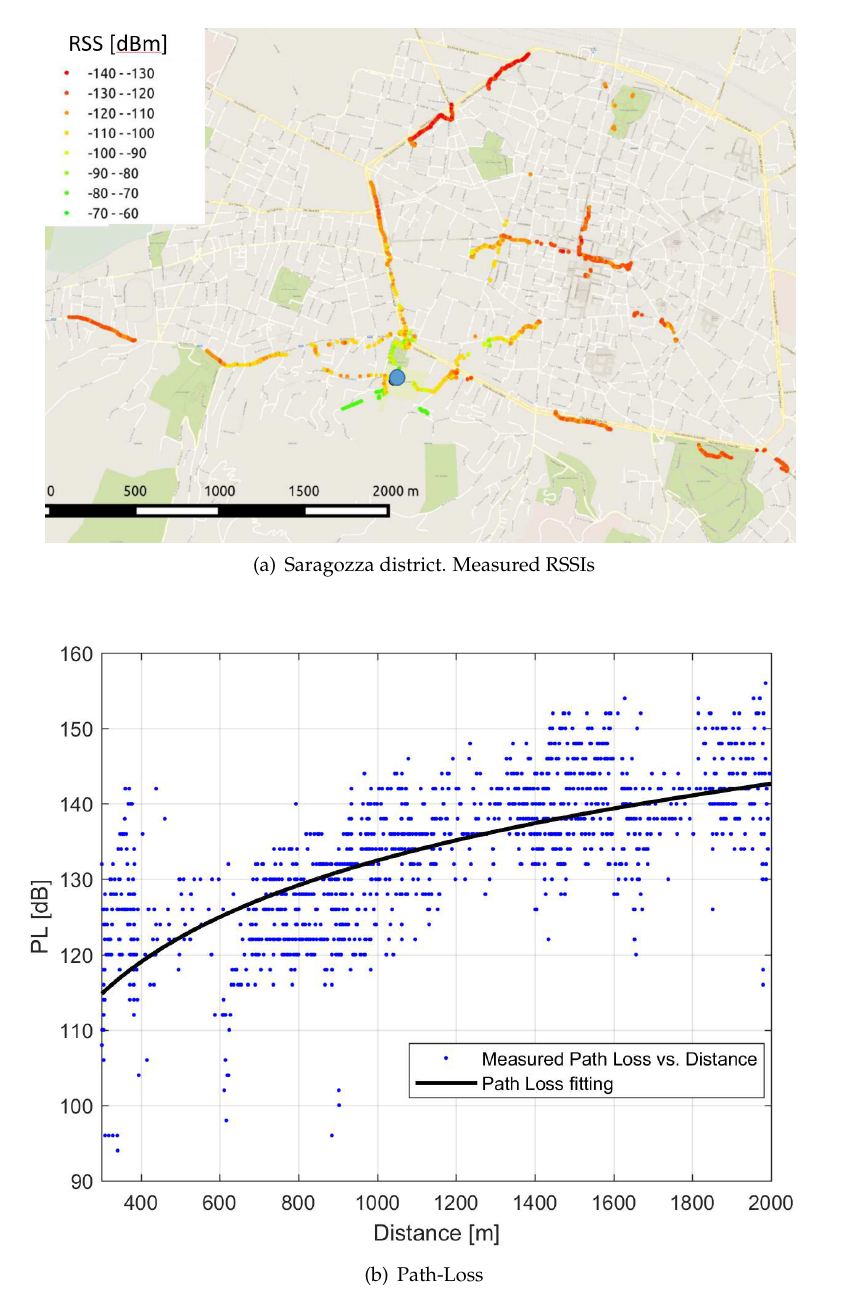
Figure 6. Saragozza district. Outcomes of the measurement